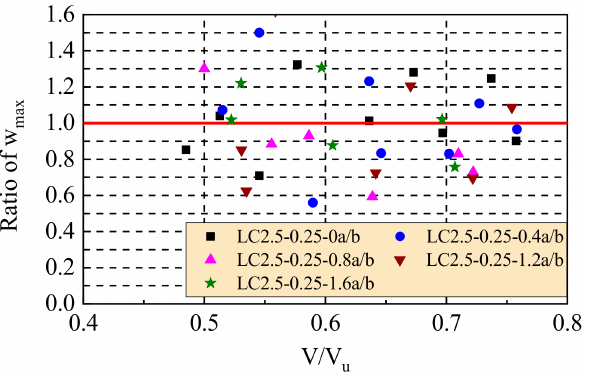
Figure 8. Comparison of test to calculation results of the maximum diagonal crack